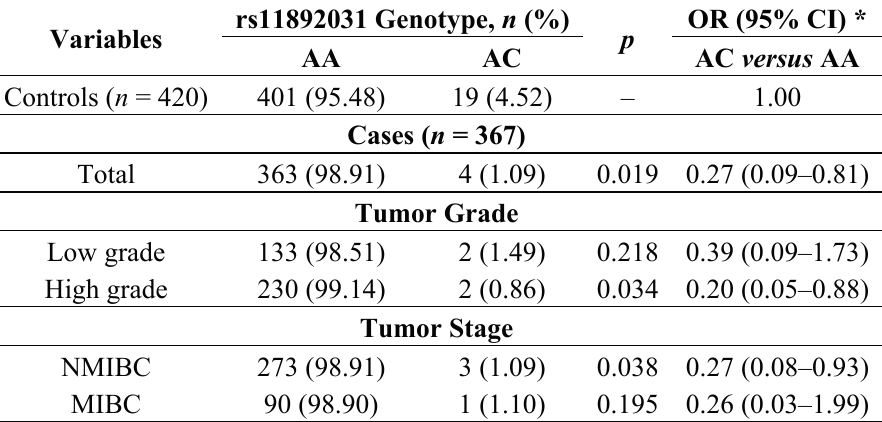
Table 3. Stratification analysis of association between rs11892031 polymorphism and bladder